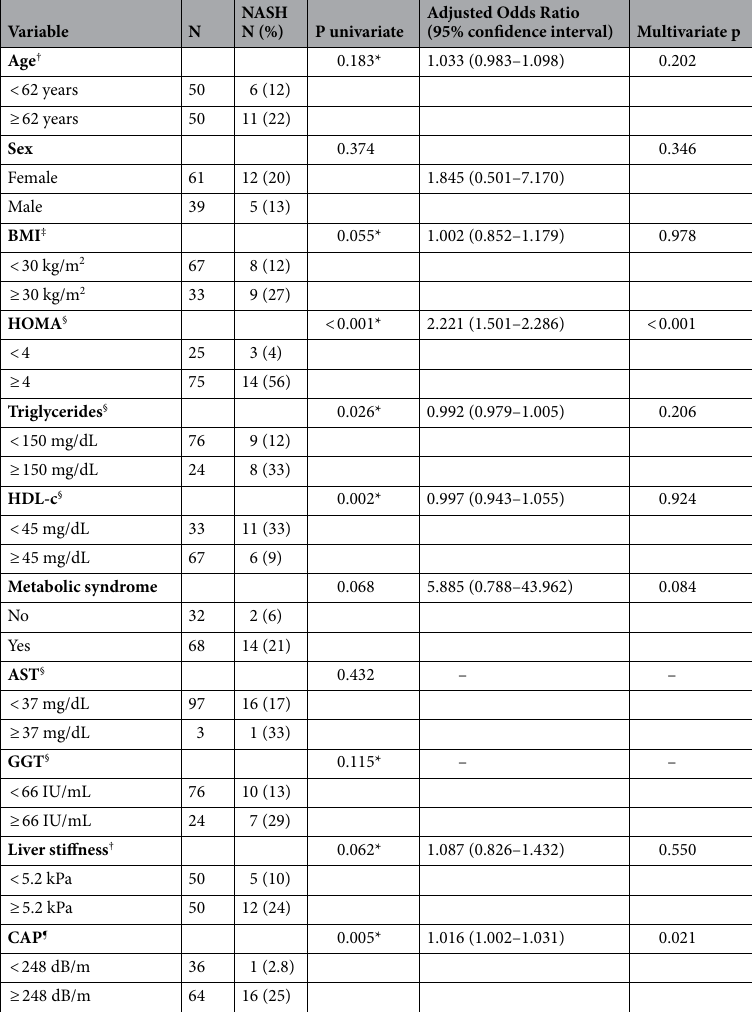
Table 4. Model to predict NASH (elaboration set, n = 100). CAP controlled attenuation parameter, BMI Body mass index, HOMA homeostasis model assessment. *Entered in the logistic regression model as continuous variables. Categories of continuous variables: † By the median; ‡ BMI ≥ 30 kg/ m 2 , indicative of obesity; § Categorized by upper limit of normal; ¶ :CAP ≥ 248 dB/m, cut-off for steatosis